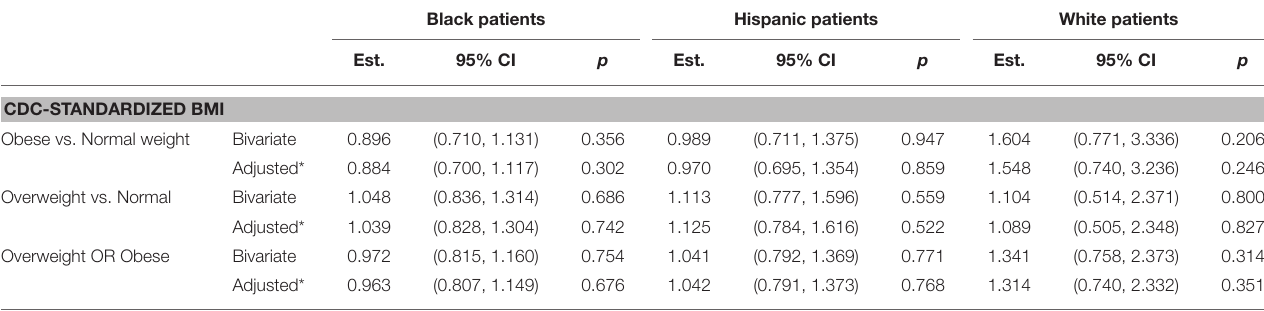
TABLE 3 | Associations between obesity, overweight and overweight or obese and poverty per CBG of patient residence. Associations are shown as odds ratios comparing those in CBGs with 20% or more of households below poverty line (high poverty) vs. those with less than 20% (low